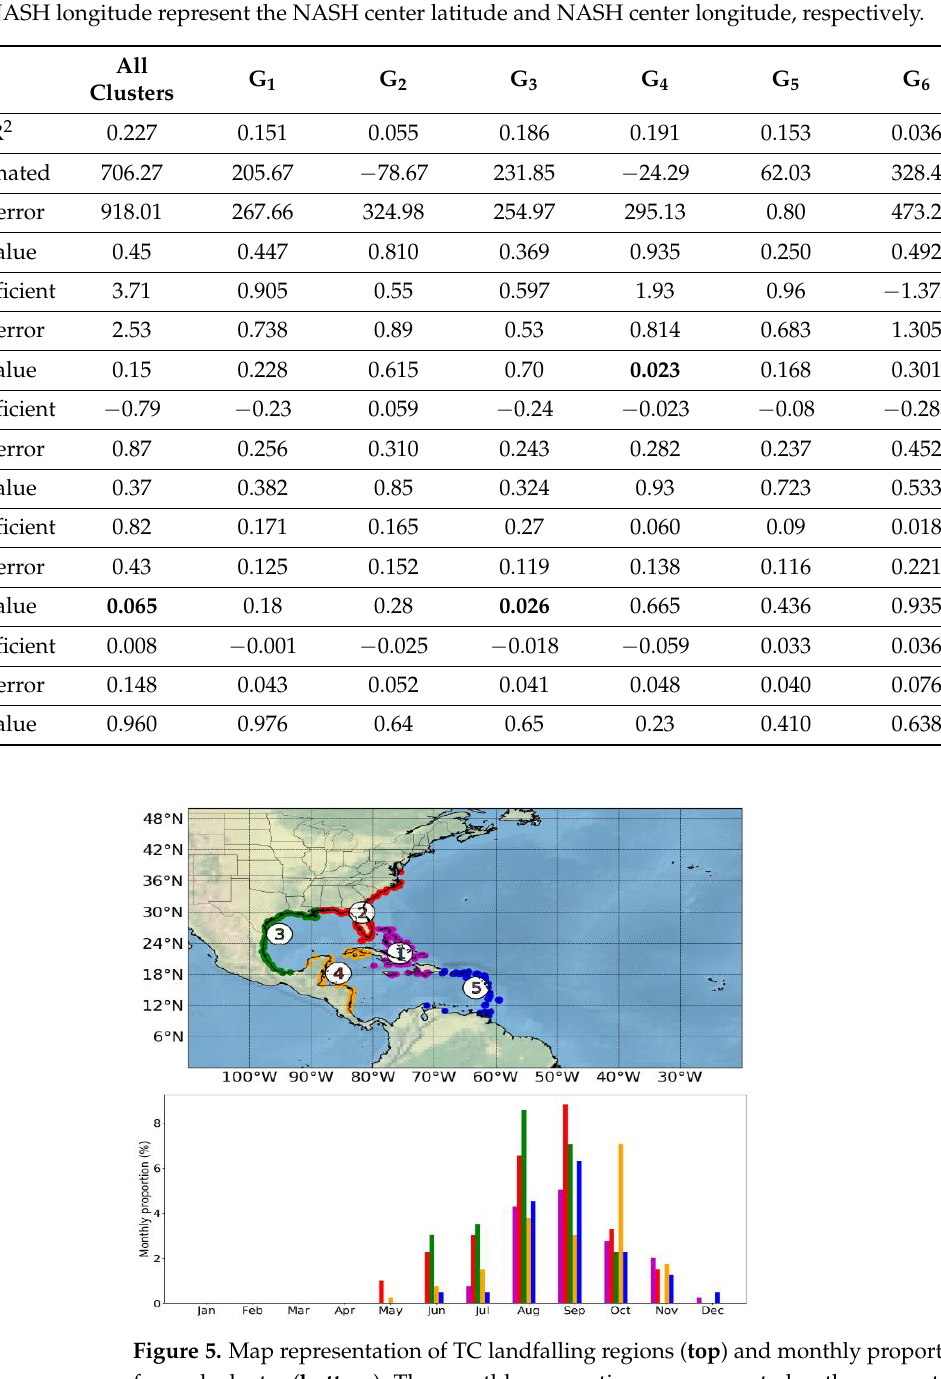
Table 2. Generalized least squares (GLS) multiple linear regression of annual NATL genesis frequency (for the whole basin and for each cluster) onto the SST and NASH (intensity and position). The SST and NASH values are based on June–November. Statistical significance is marked with bold text ( p < 0.05). SST is in ◦ C and NASH intensity in hPa. NASH latitude and NASH longitude represent the NASH center latitude and NASH center longitude, respectively.